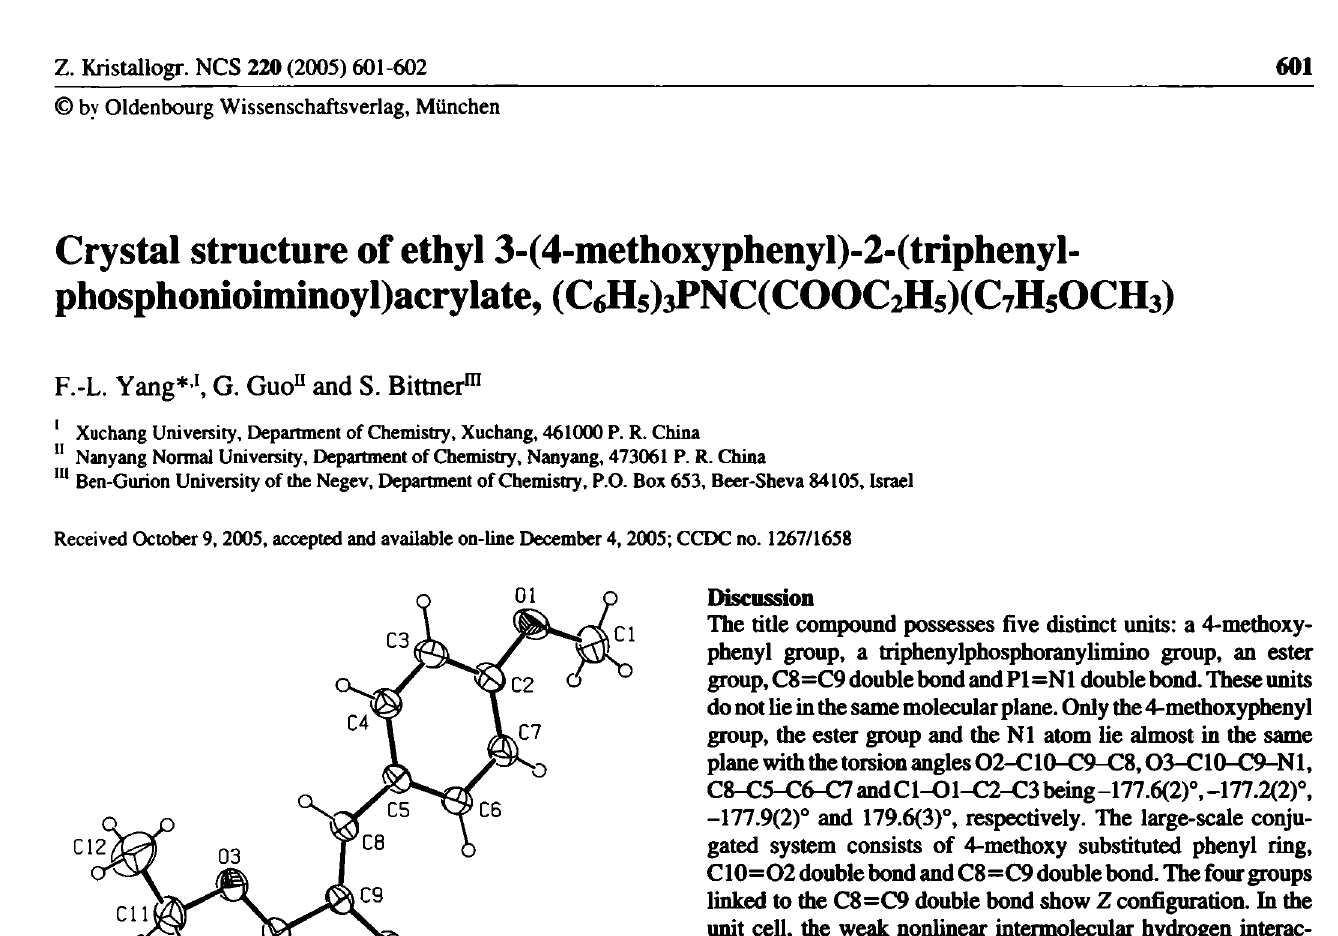
Table 1. Data collection and handling.